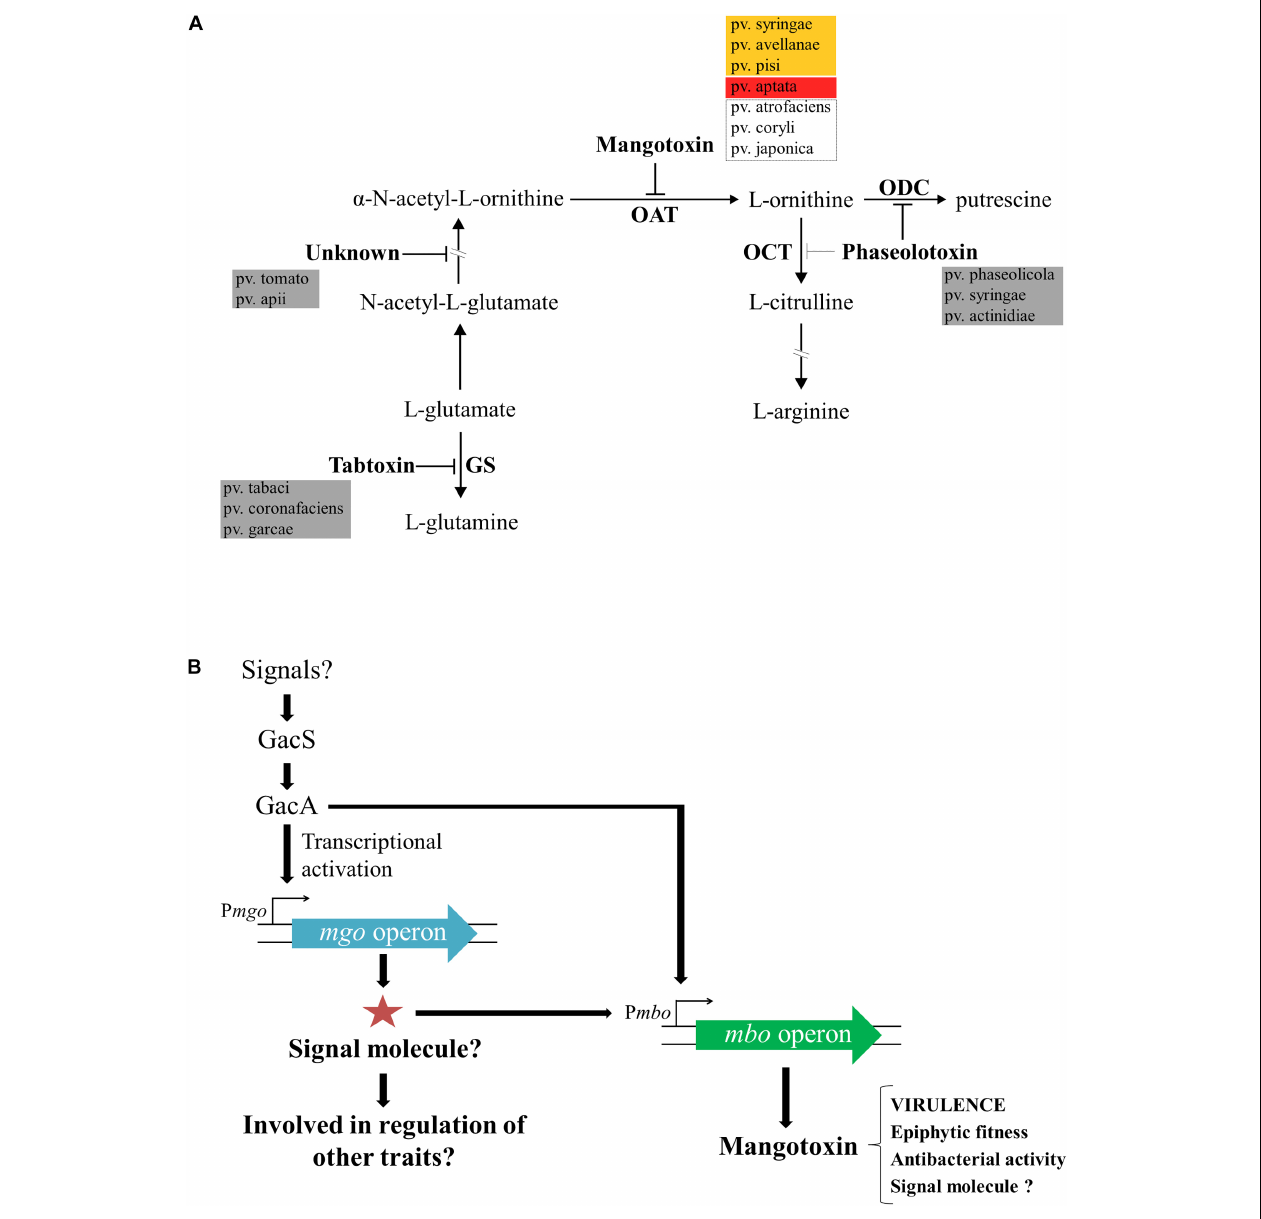
FIGURE 3 | Enzymatic target of mangotoxin and its biosynthesis regulation. (A) Representative scheme of the arginine-glutamine and polyamine biosynthesis pathways. The enzymatic targets of the different antimetabolite toxins, including mangotoxin, and the different pathovars involved in the production of the different antimetabolite toxins are depicted. OAT, ornithine N -acetyltransferase; OCT, ornithine carbamoyltransferase; ODC, ornithine decarboxylase, and GS, glutamine synthetase. Orange box: pathovars positives for the presence of mbo genes and positives for mangotoxin production; red box: pathovar positive for the presence of mbo genes, but negative for mangotoxin production; dotted lines box: pathovars positive for the presence of mbo genes, but not experimentally tested for mangotoxin production. (B) Mangotoxin biosynthesis regulation model. GacS/GacA two-component regulatory system regulates directly or indirectly the transcription of the mgo operon. Mgo operon could synthetize a positive regulator (signal molecule) to activate the mbo operon transcription. The mbo operon produces mangotoxin, which acts primarily as a virulence factor, although, other functions have been